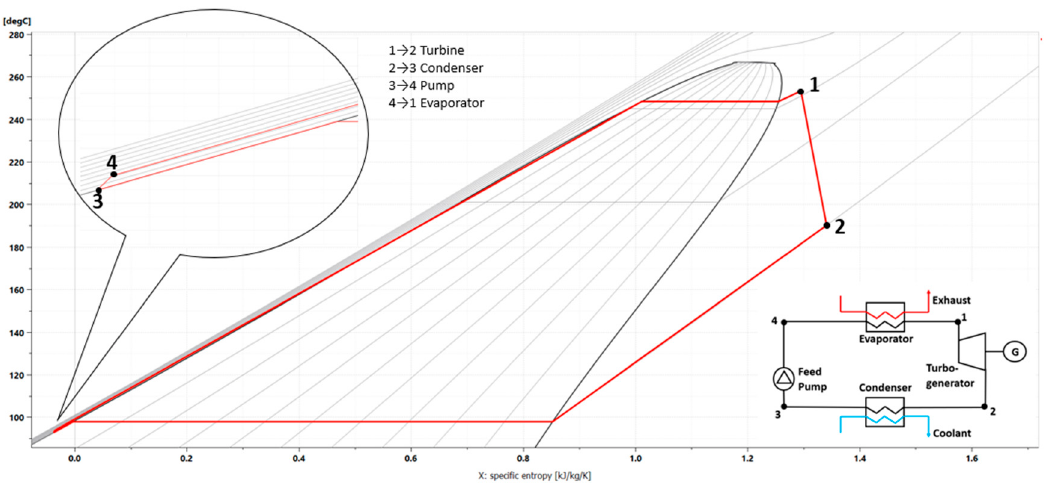
Figure 1. T-s diagram of a simple ORC with heptane (subcooled and superheated).